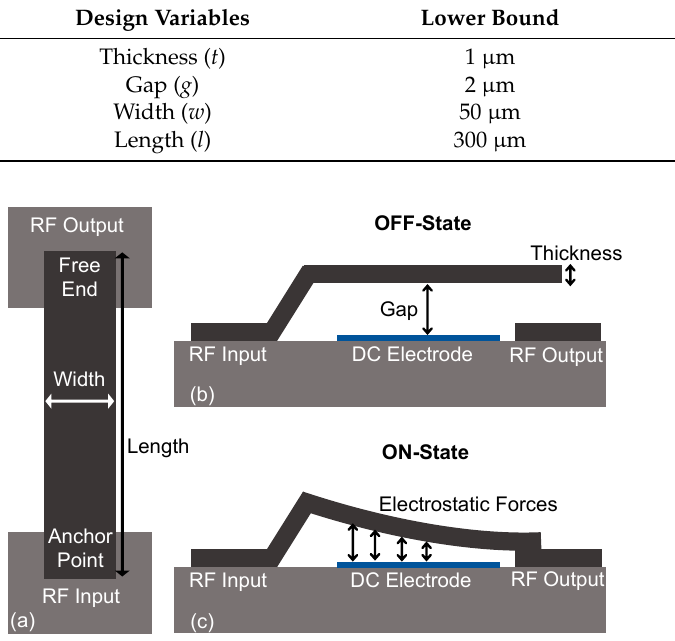
Figure 6. Cantilever-based series RF-MEMS switch: ( a ) top view; ( b ) side view in OFF-state; and ( c ) side view in ON-state. Table 3. Design variables for RF-MEMS switch.